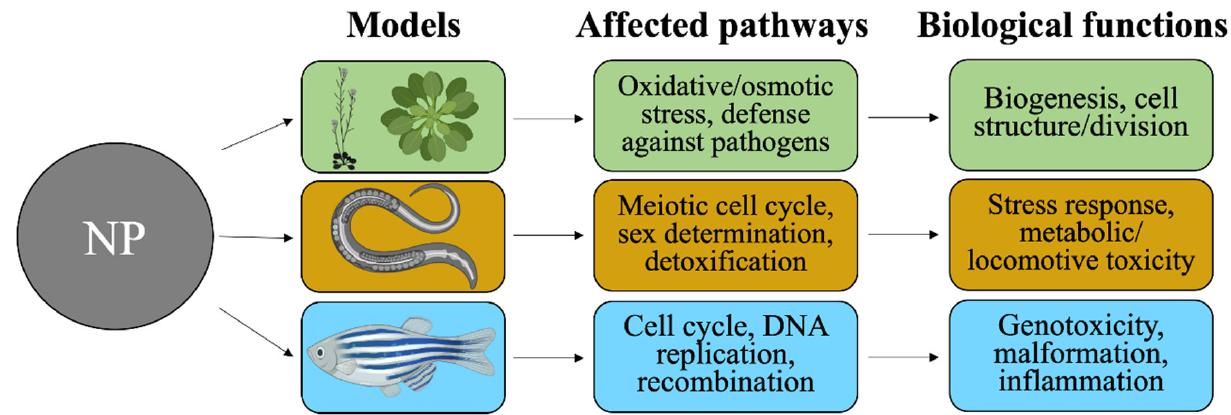
Figure 2. NP-driven environmental effects studied in different ecotoxicology-related models. Ara- bidopsis thaliana plants, C. elegans nematodes and Danio rerio zebrafish represent soil and aquatic species that are conventionally used for ecological toxicity assessment. Transcriptomic analyses yield DEGs, which identify the major affected pathways and the associated biological functions. Created with BioRender.com (https://app.biorender.com, accessed 25 March